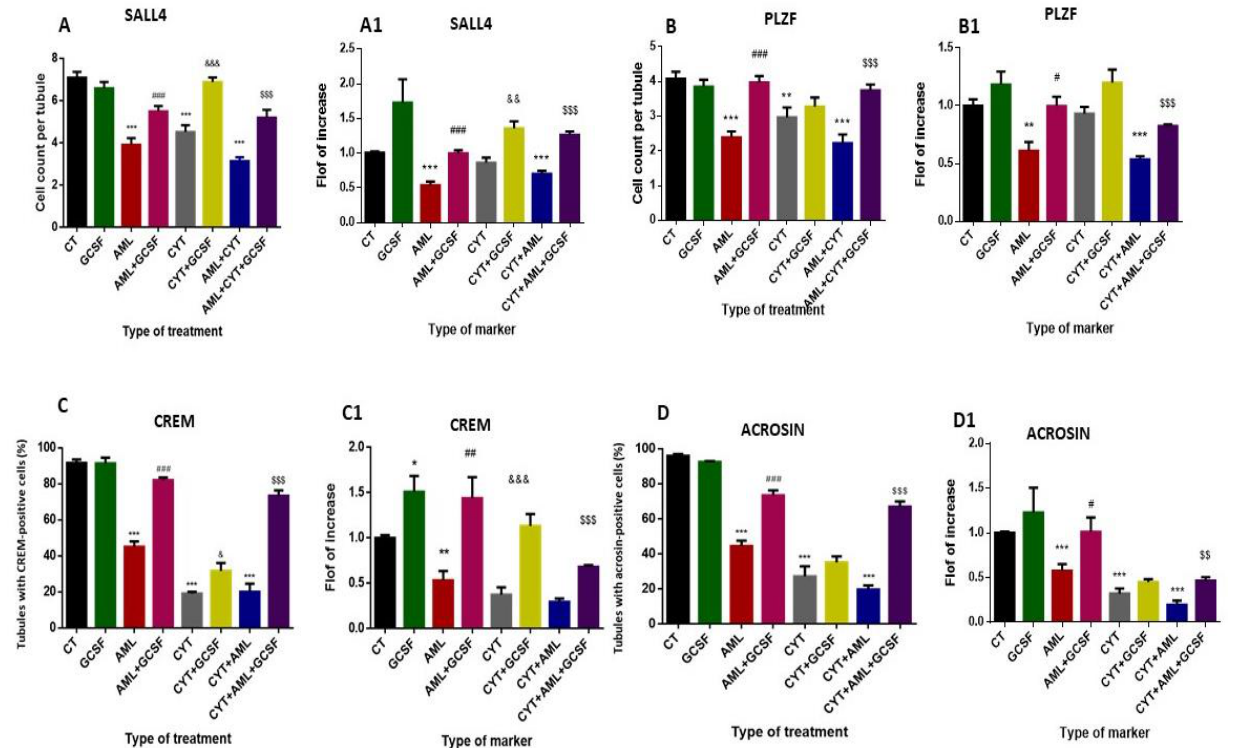
Figure 5. Effect of GCSF on the pre-meiotic, meiotic and post-meiotic cell and their expression levels in testes of AML- and CYT-treated groups. Mice were treated as described in Figure 2. Testicular sections from different groups of treated mice were examined by immunohistochemical (IHC) staining as we described in Figure 1C for the pre-meiotic cell markers (SALL4 and PLZF), for the meiotic marker (CREM) and for the meiotic/post-meiotic marker (ACROSIN) using specific antibodies for each marker. The number of stained cells/seminiferous tubule for SALL4 ( A ), PLZF ( B ) was counted. The percentages of tubules with >10 cells of CREM-positive stained cells ( C ) or ACROSIN-positive stained ( D ) were counted. The RNA expression levels of SALL4 ( A1 ), PLZF ( B1 ), CREM ( C1 ) and ACROSIN ( D1 ) in testes of all examined groups were tested by qPCR analysis using specific primers for each marker. qPCR results are presented as fold of increase compared to the control group (CT). The results are representative of 3 independent experiments with 3–5 mice in each group per experiment. *—significant compared to control (CT). #—significant compared to AML, &—significant compared to